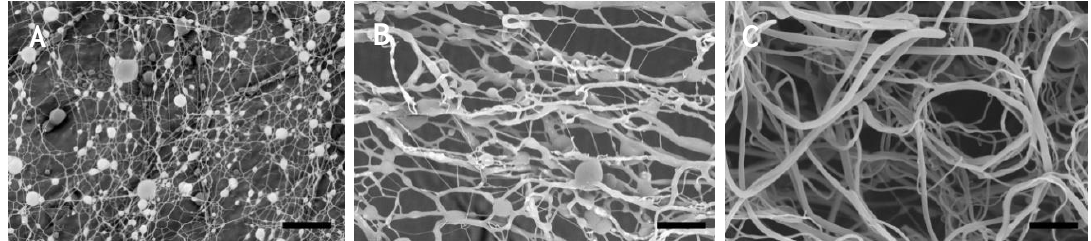
Figure 3. SEM images of the 3 prediction runs at 4000 × , where the coordinates for Run ( A ) are (5, 8, 18, and 14), Run ( B ) are (8, 13, 15, and 24), and Run ( C ) are (14, 15, 10, and 18). Scale bar is 15 µm. Table 1. Experimental and predicted ln fiber diameter (FD) and ln number of beads present per µm 2 (NB) values for three experiments.